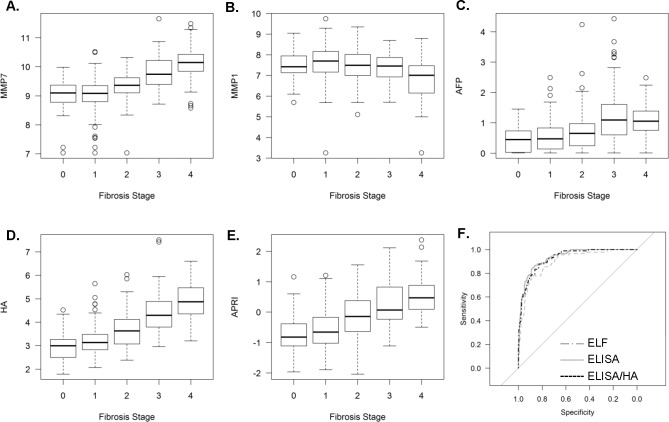
Components of Logistic Regression Model for Predicting Advanced Fibrosis.Serum MMP7 (A), MMP1 (B), AFP (C), HA (D) and the APRI (E) were selected in the optimal linear regression model for advanced fibrosis (ELISA/HA model). (F) AUROCs for the ELISA, ELF/HA and ELF models.